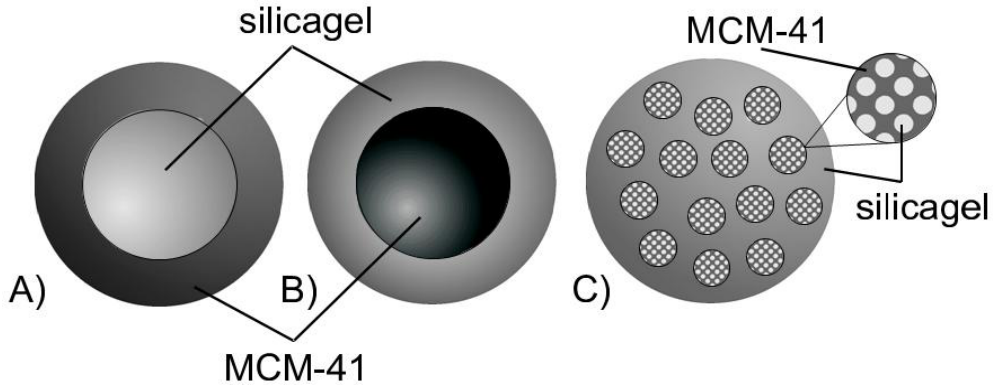
Figure 8. Schematic representation of products from partial pseudomorphic transformation showing the possible spatial arrangements of regions comprising initial (silica gel) and transformed (MCM-41) material ( A , B ) core-shell models; ( C ) homogeneous distribution